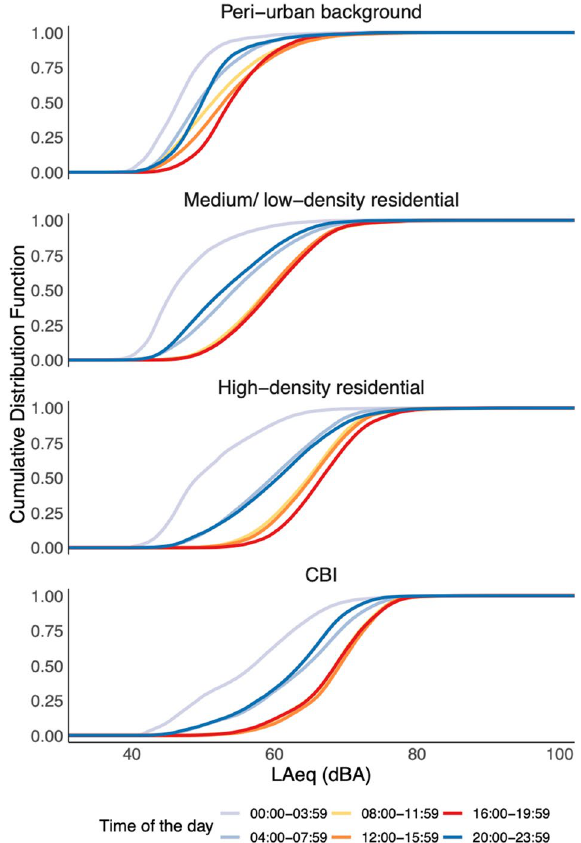
Figure 2. Cumulative density (distribution) functions (CDF) of 1-min sound levels (dBA) across a 24-h day period in the Greater Accra Metropolitan Area. Data from rotating sites. Blue lines represent time periods in the nighttime and early morning (8 pm–8 am) and red and orange lines represent periods in the daytime (8 am–8 pm). CBI: Commercial, business, industrial areas; LAeq: 1-min A-weighted equivalent continuous sound level; dBA: A-weighted